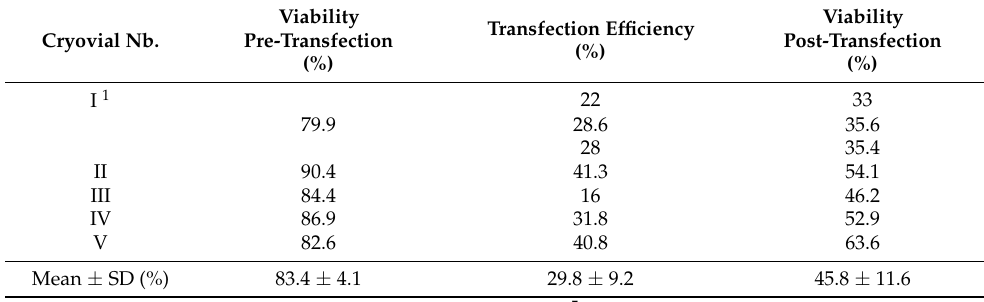
Table 2. Influence of the batch variation on transfection efficiency and viability. Cryovial